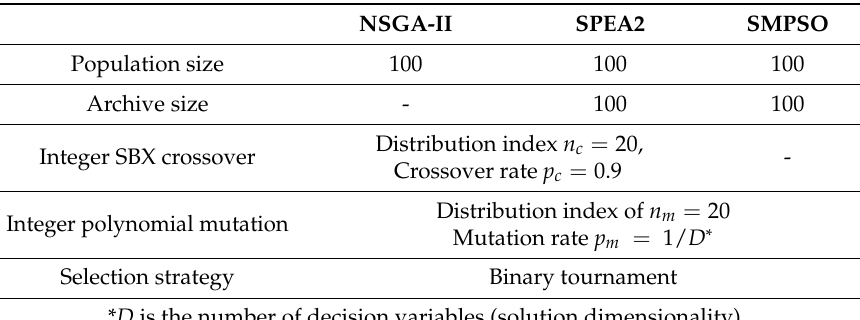
Table 2. Parameters values of NSGA-II, SPEA2, and SMPSO methods.